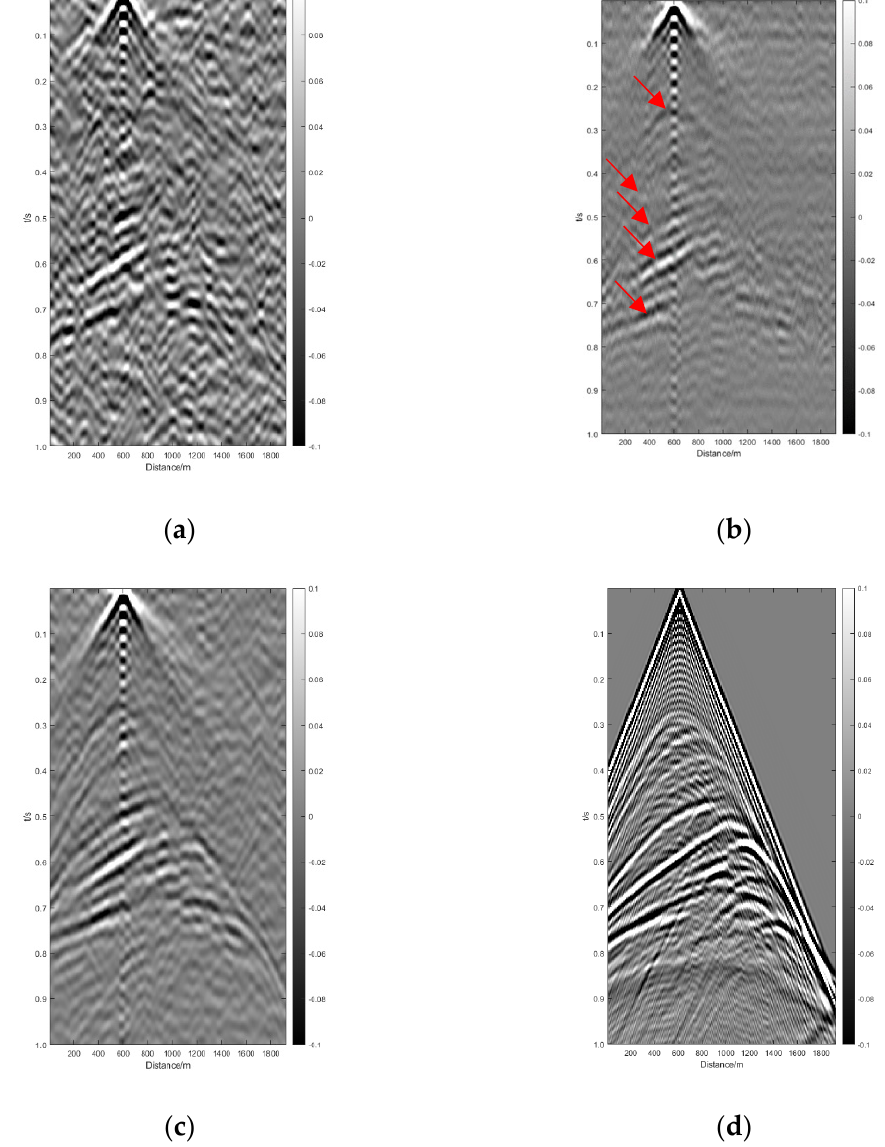
Figure 9. The 60th trace set effect display. ( a ) The reconstructed result of passive seismic records with short periods; ( b ) the result of the test data processed by the neural network; ( c ) the recon ‐ structed result of passive seismic records with long periods. ( d ) Active ‐ source forward modeling result.